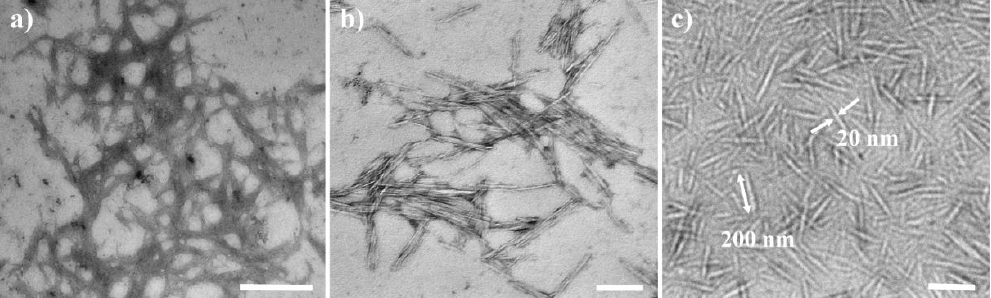
Figure 2. Transmission electron microscope (TEM) of ( a ) MCC, ( b ) NCC and ( c ) DANC; scales of ( a ) is 1 μm, ( b , c ) are 200 nm.